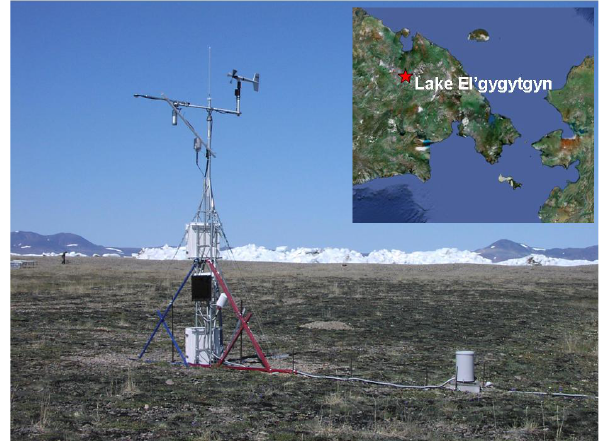
Fig. 1. Automated weather station with wind-shoved lake ice in the background. This station ran essentially unattended from 2002 to 2009. Inset shows location of lake in northeastern Siberia, above the Arctic